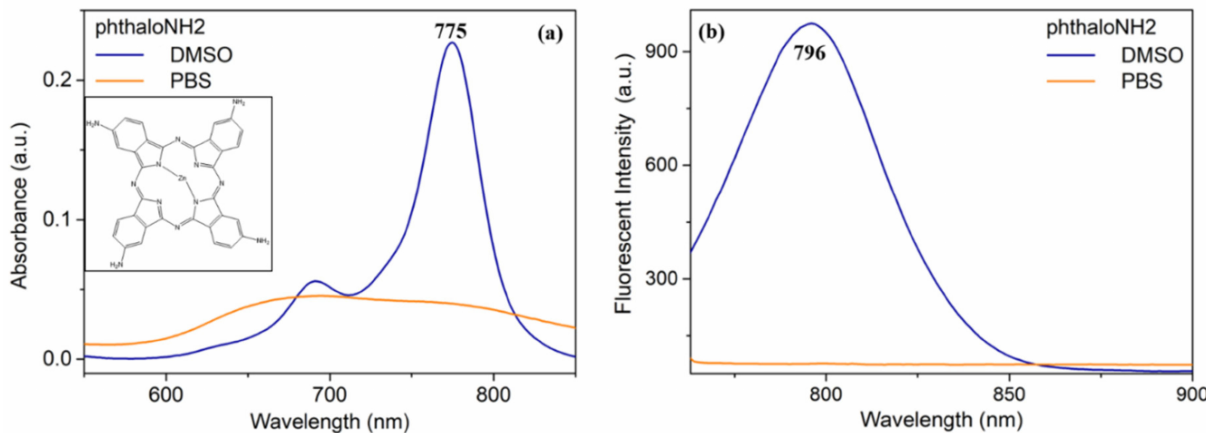
Figure 1. Absorbance ( a ) and fluorescence emission ( b ) spectra of the free phthaloNH 2 molecules in DMSO (blue) and PBS (orange) solutions. The chemical structure of phthaloNH 2 can be found in inset ( a ). For both samples, the excitation wavelength was fixed at 745 nm. We used a concentration of 10 − 5 M phthaloNH 2